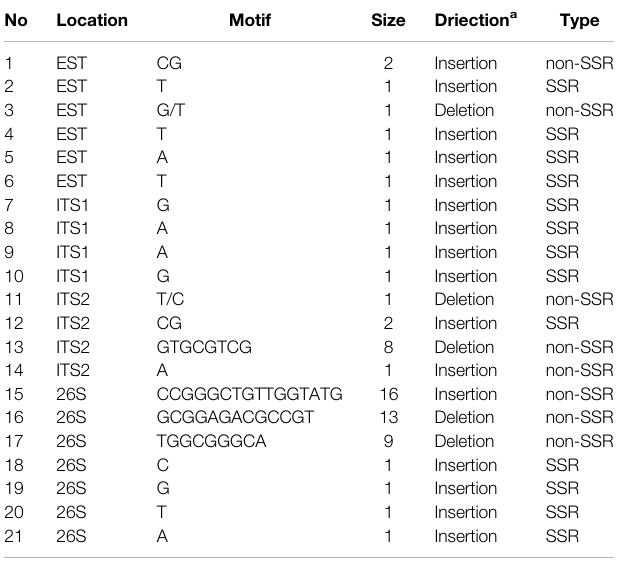
TABLE 4 | Forms and numbers of indel mutational events in the nrDNA between the genera of Eriobotrya and